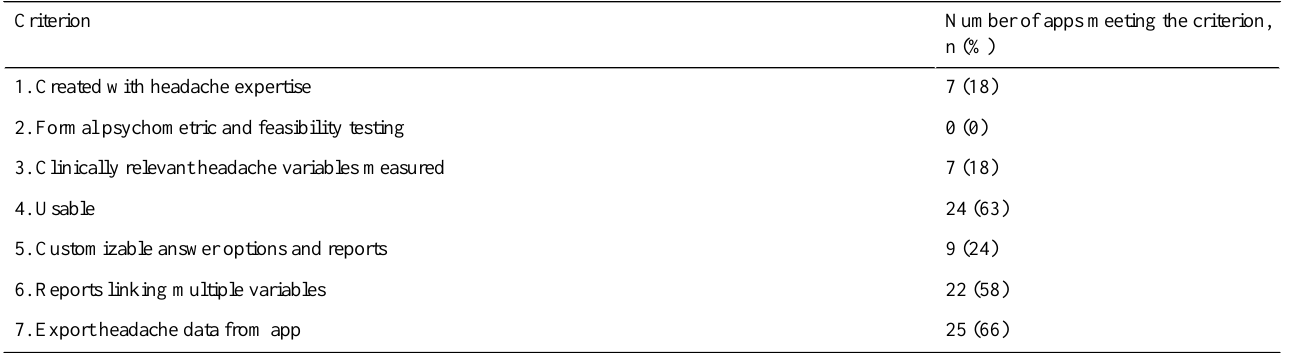
Table 4. Number of apps meeting each app criterion (N=38).